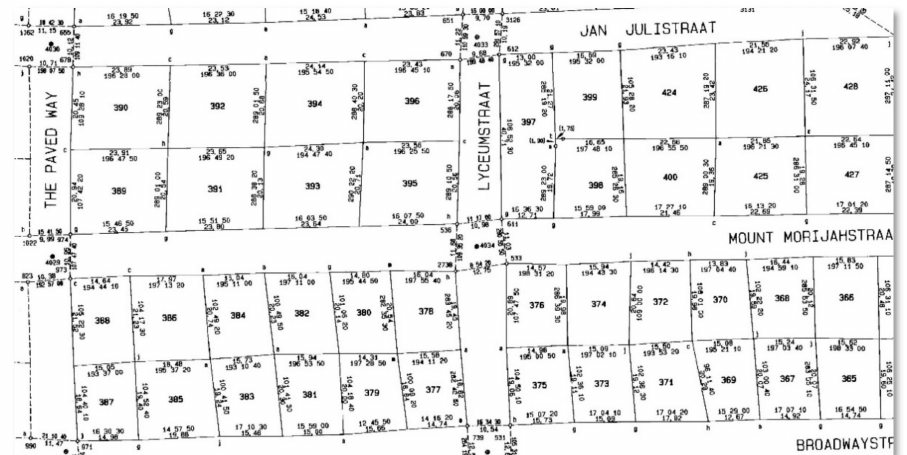
Figure 12. Extract from a 1985 general plan of a township with 1092 erven known as Makeleketla, Administrative District of Winburg, Free State Province [16] (Reference: S.G. L. No. 854/1985). The line intersections were determined by fixing the positions of the fence corner